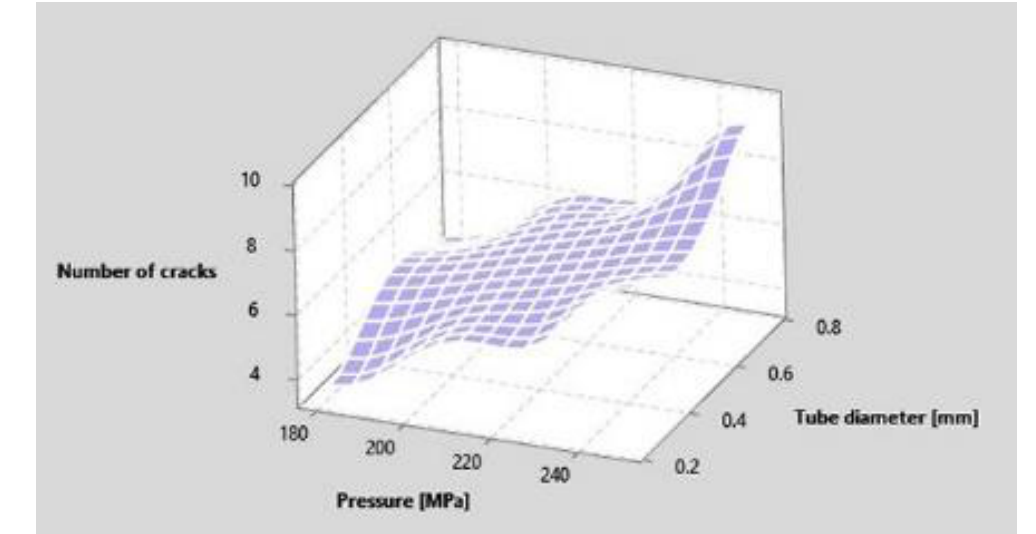
Figure 7. Dependence of number of cracks on pressure and tube diameter. Table 6. Parameters proposed for Taguchi optimization.